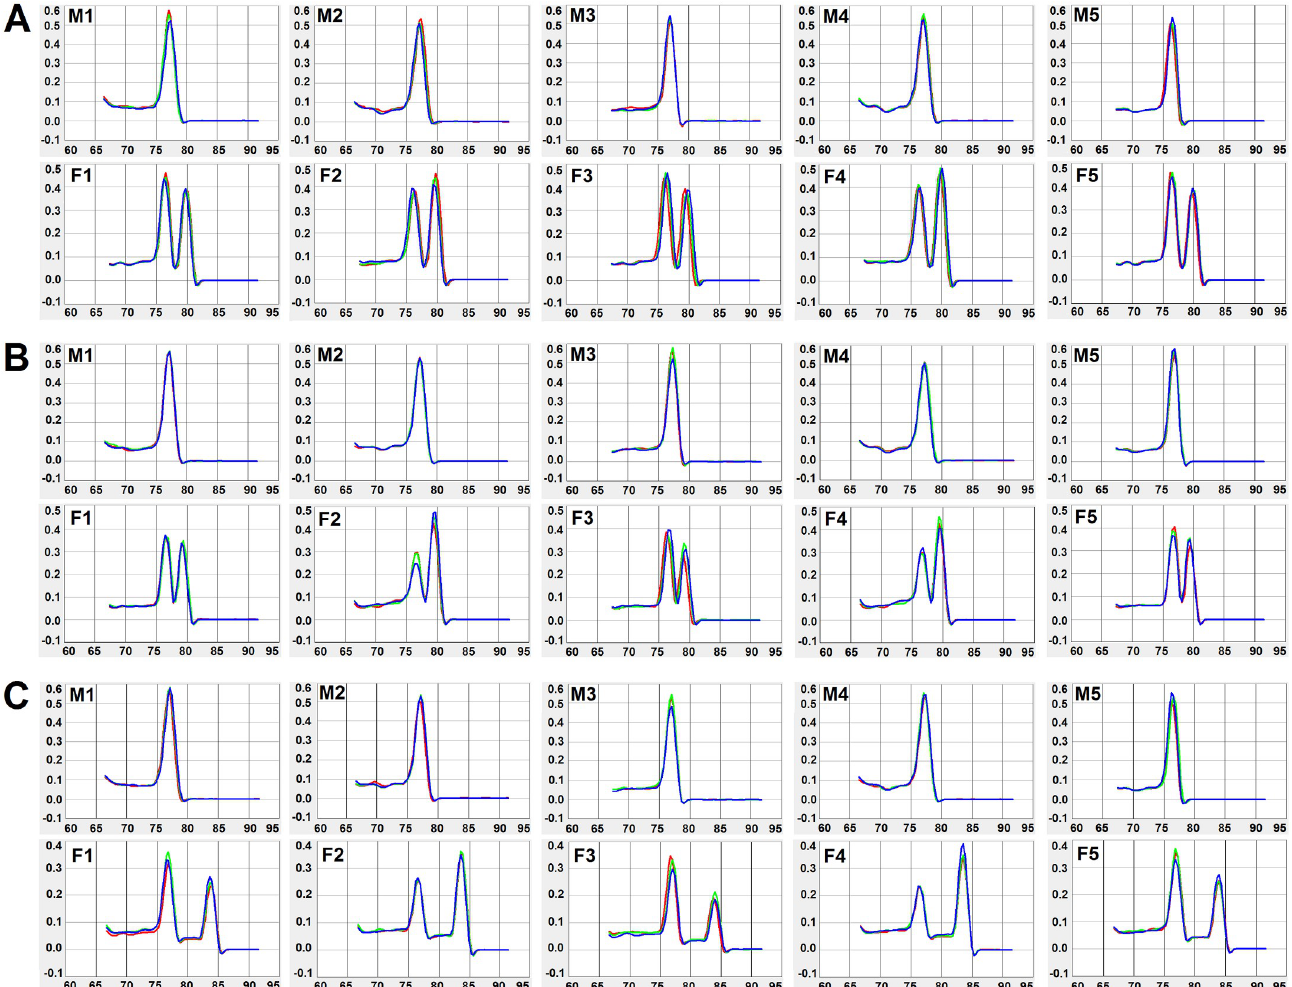
Fig 4. Duplex qPCR for sexing cercariae. Duplex qPCR melt curve analysis of W chromosome-specific gene markers SjF4 (A), SjF6 (B) and SjF9 (C) using male and female cercariae. M1–5 represent male cercariae released from five snails; the single peak corresponds to the reference gene PSMD4 . F1–5 represent female cercariae released from five snails; the two peaks correspond to PSMD4 (first peak) and W chromosome-specific genes (second peak).